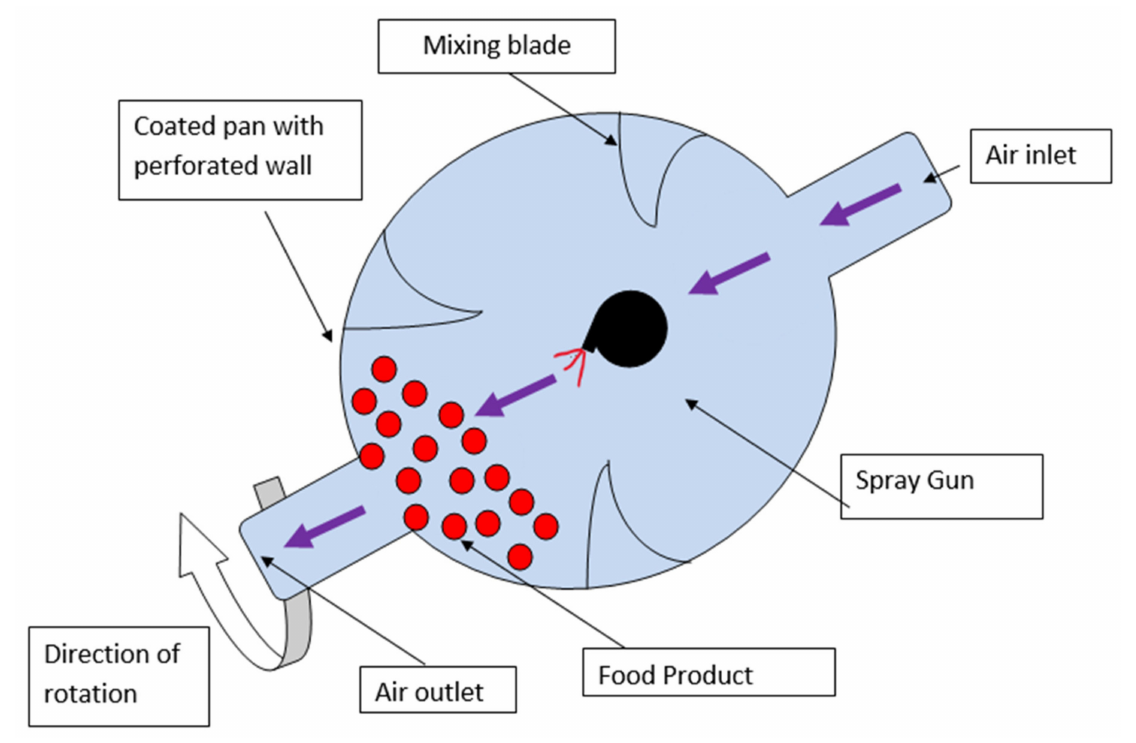
Figure 6. Panning method of edible